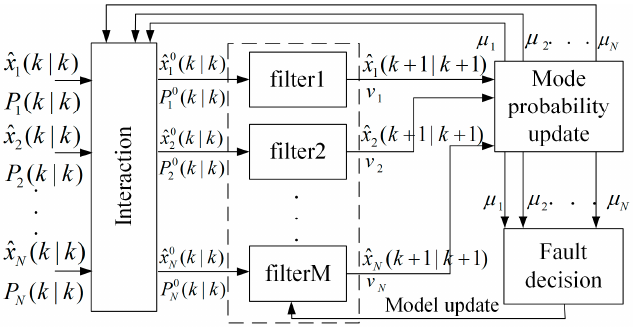
Figure 3. The block diagram of the UIMM.